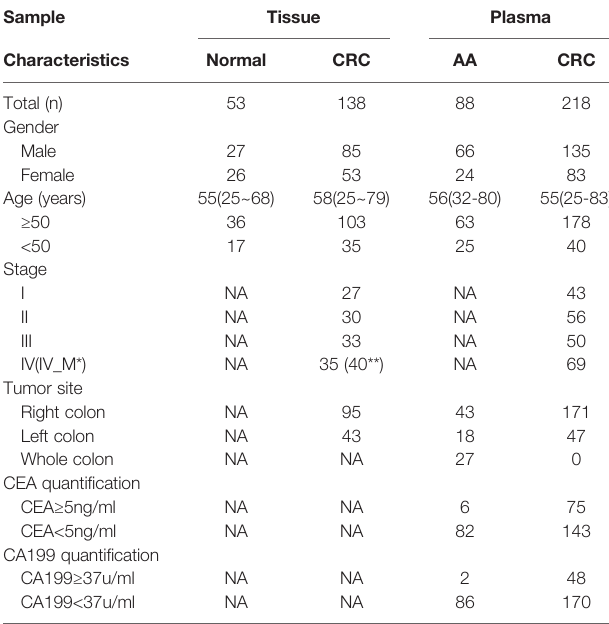
TABLE 1 | Clinical characteristics of the quali fi ed tissue and plasma